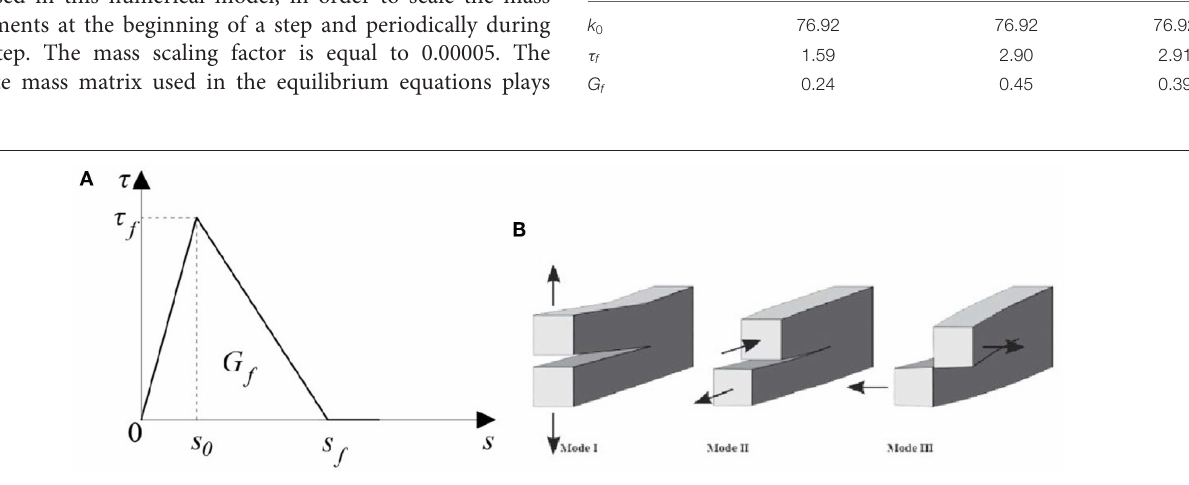
FIGURE 5 | Interface modeling: (A) bond slip law and (B) mode I, mode II, and mode III.